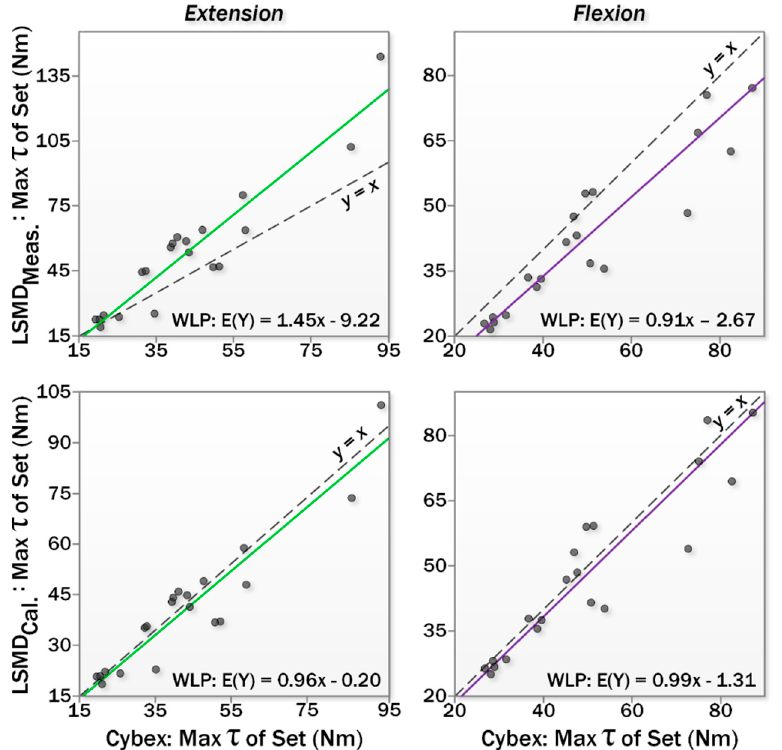
Figure 5. Weighted least squares regressions for LSMD versus IKD for extensors ( left ) and flexors ( right ), as measured ( top ) and after post-hoc calibration ( bottom ).